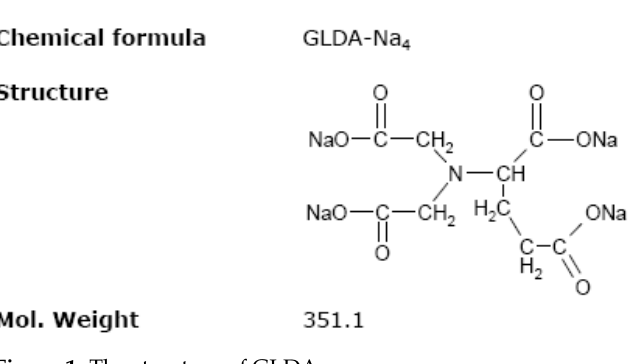
Figure 1. The structure of GLDA. Table 3. Leaching removal rate of heavy metal Pb under different treatments (%).